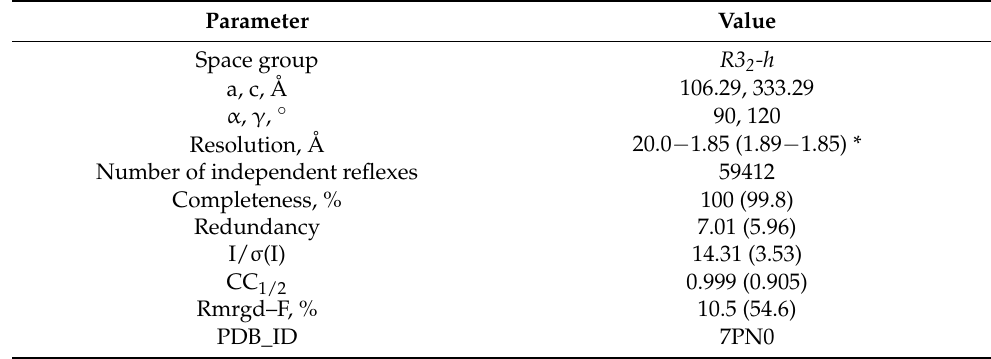
Table 1. Statistical characteristics of the experimental dataset and the results of the refinement of the structure of the rhombohedral